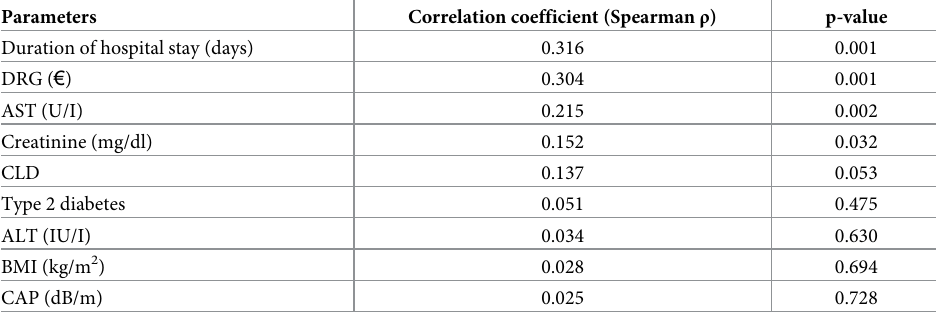
Table 2. Correlation between liver stiffness and clinical and laboratory parameters.